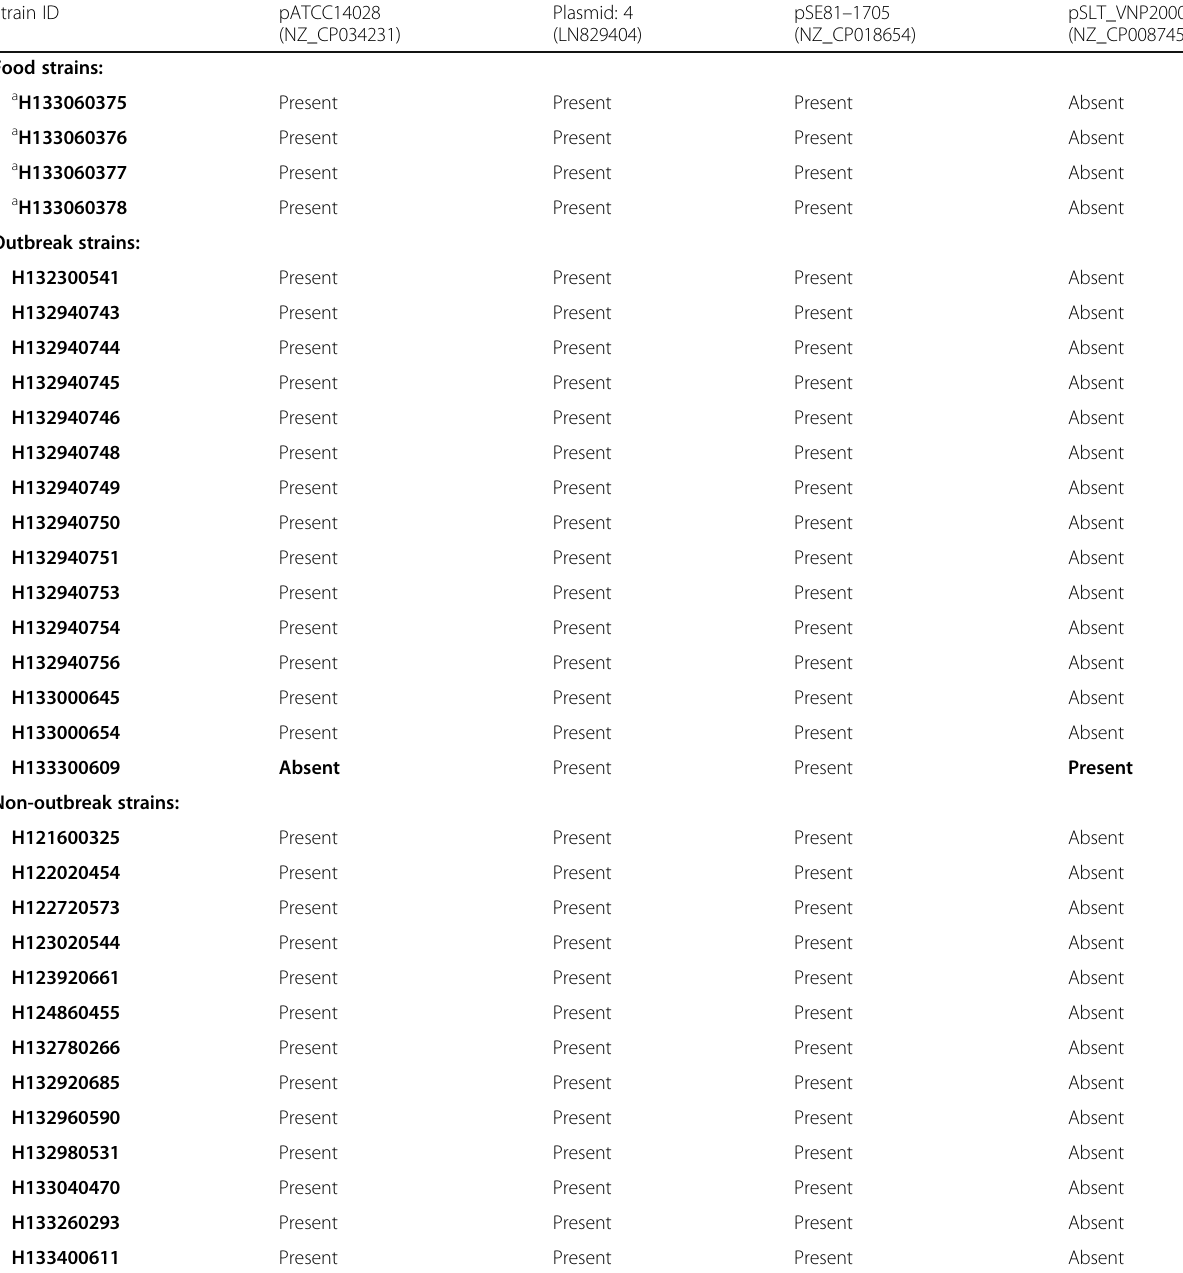
Table 6 Distribution of plasmids among outbreak and non-outbreak strains of Salmonella Typhimurium Strain